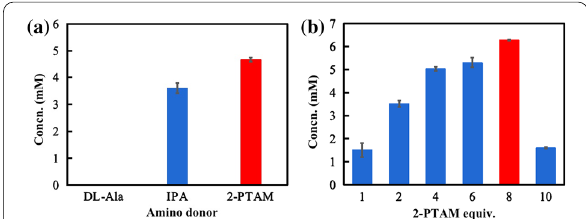
Fig. 2 Optimization of the kind ( a ) and equivalents ( b ) of amino donor in Module 2. Reaction conditions (0.5 mL): shaken at 35 °C, 800 rpm for 12 h, KPB buffer (pH 7.5, 100 mM). The reaction mixture (0.5 mL) was composed of 10 mM ( )‑perillyl alcohol (with 2% − DMSO), 0.2 U/mL Lk ADH, 0.4 U/mL Sm NOX, 2 U/mL ATA‑117, 0.2 mM PLP, 0.2 mM NAD + , in addition to: a 50 mM DL‑Ala/ IPA/2‑pentanamine; b